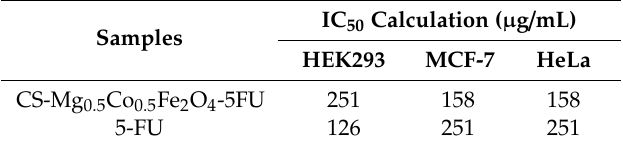
Figure 4. MTT cell viability assay in human cell lines ( A ) HEK293, ( B ) MCF-7, and ( C ) HeLa. (** p < 0.01, * p < 0.05) was considered statistically significant, and the mean data is represented as means ± SD ( n = 3). Table 2. IC 50 values of free 5-FU and 5-FU-loaded nanocomposites in HEK293, MCF-7 and HeLa cells for the MTT assay.